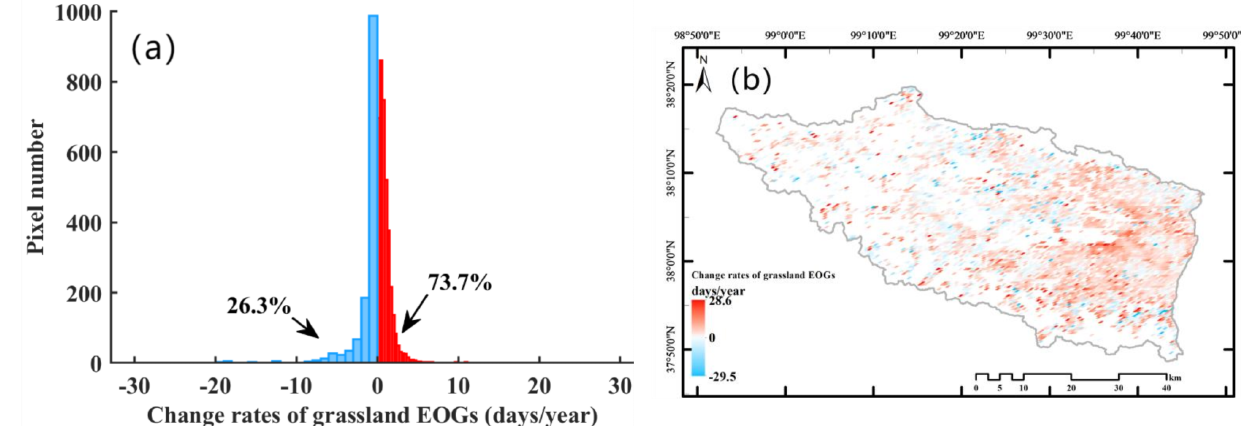
Figure 11. ( a ) EOG annual rate of change; ( b ) change rates of grassland EOG in the Muli region from 2014 to 2021.